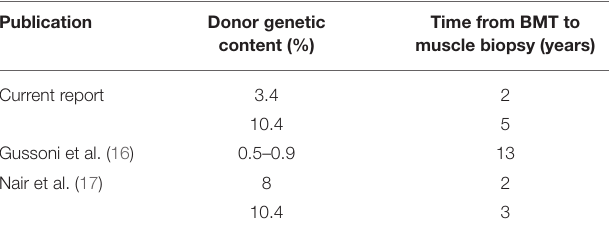
TABLE 1 | Comparison of bone marrow donor genetic material in muscle tissues compared with prior